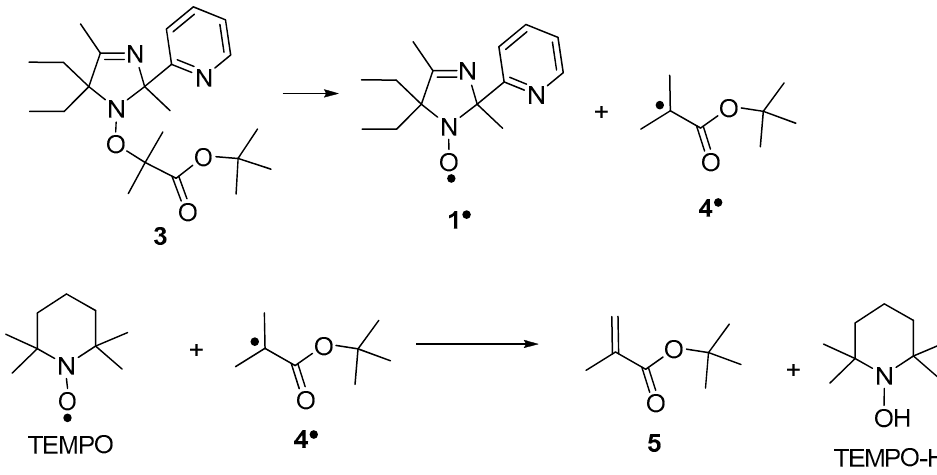
Figure 7. Eyring plot for epimerization reaction of 2 RS/SR diastereomer.